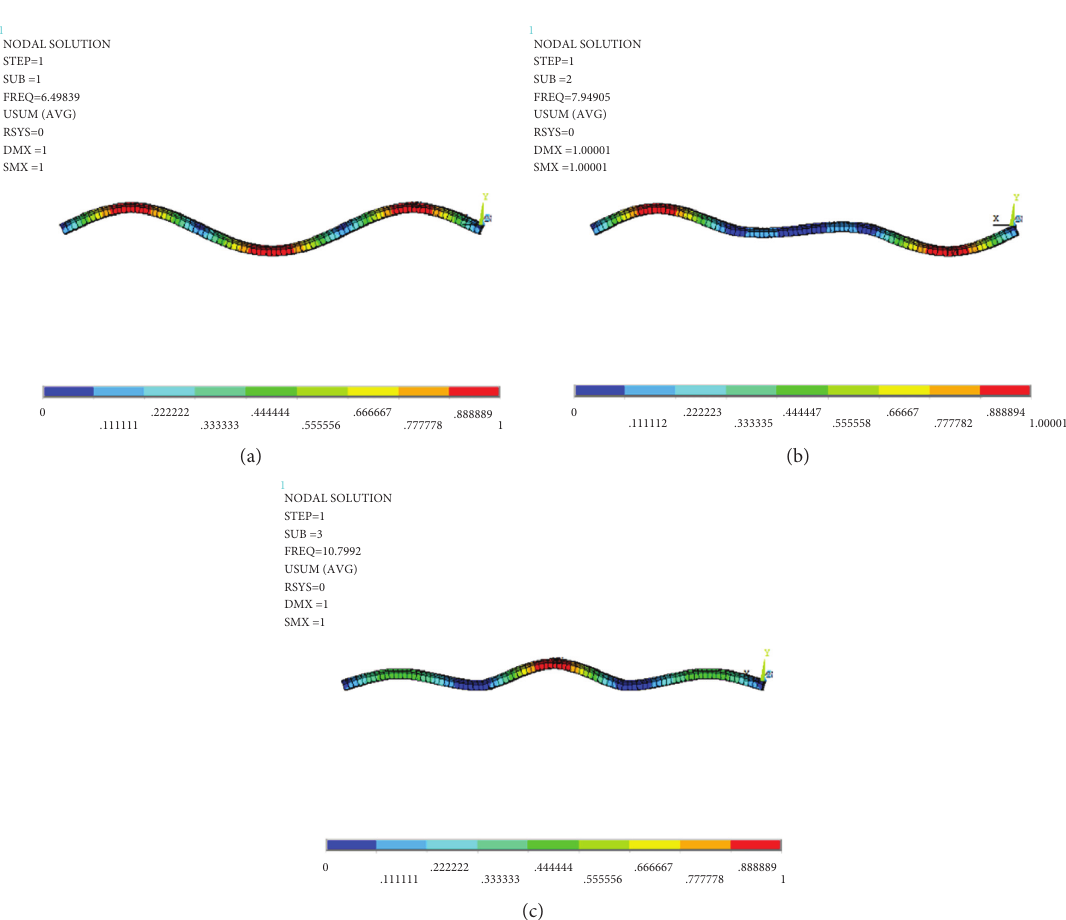
Figure 21: Vibration modes for 1st (a), 2nd (b), and 3rd (c) order of three-span continuous girder.